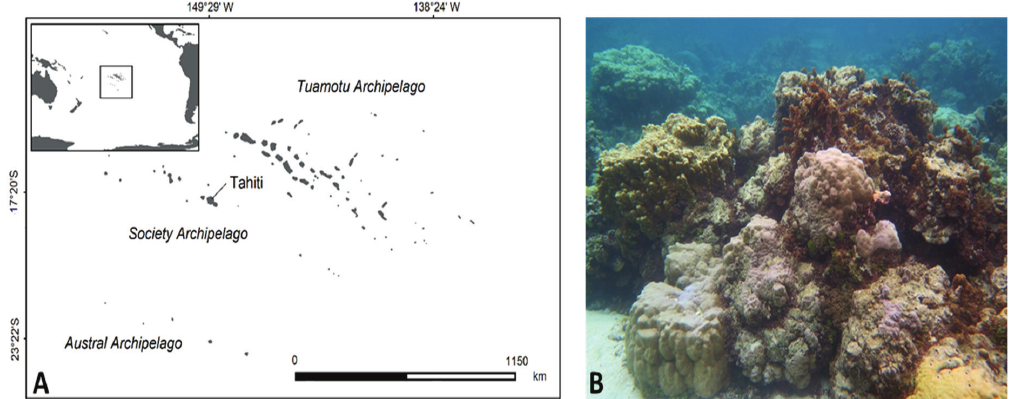
Figure 6. Localization of Tahiti Island ( A ) and illustrations of habitat ( B ).